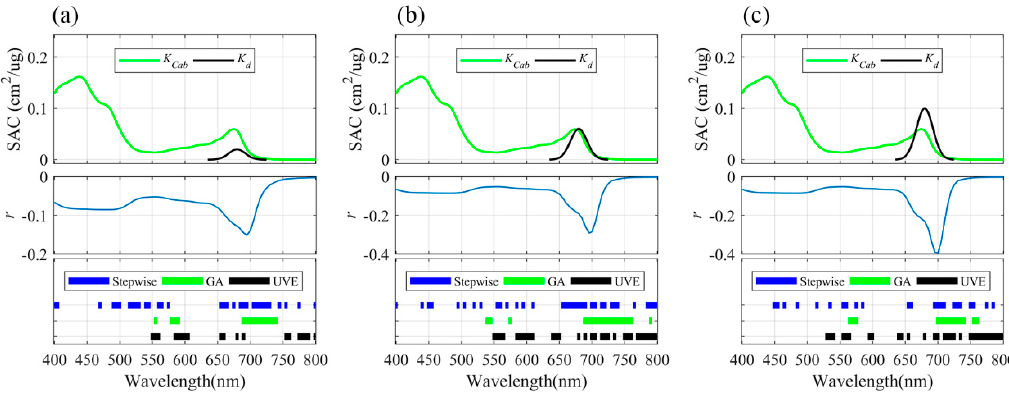
Figure 2. Bands selected in PLSR models with three different variable selection/elimination approaches to estimate C d with different absorption intensities: ( a ) 0.02 cm 2 /ug; ( b ) 0.06 cm 2 /ug; and ( c ) 0.10 cm 2 /ug. The locations of absorption peak and half-widths shown were set to 680 nm and 30 nm, respectively.